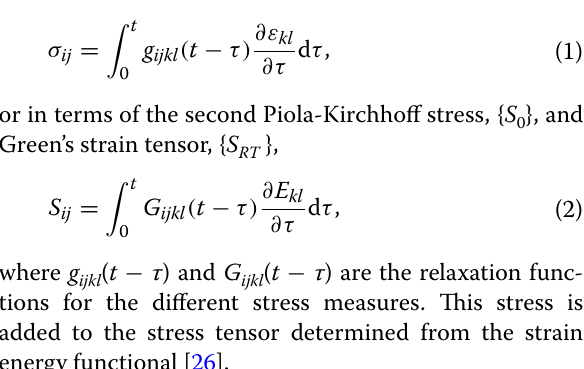
ratio is 0.495. Firstly, with the initial boundary condi- tions applied, a same sized discrete model of the rubber specimen has been established, as shown in Figure 2(a). Solid elements with one integration point were chosen for large deformation analysis of the tire rubber material. This element is sufficient efficient and accurate, however, hourglass control is also needed in each case [14]. Sec- ondly, a test prescribed motion was applied on the top surface of the specimen to simulate its uniaxial compres- sion. Finally, the axial forces will be compared between simulations and test results for material correlation. The force versus displacement curves acquired from numerical simulation and test data with different strain rates are shown in Figure 3(a). It can be seen that the curves from experimental and numerical tests have good agreement for various strain rate, and evident strain rate dependency can be noticed. The comparisons results show that the constitutive model selected can accurately describe the response of rubber specimen during com- pression with various strain rates. In addition, the test data of tire rubber with high strain rate (5700 s − 1 and 3800 s − 1 ) were acquired from dynamic split Hopkinson pressure bar test by Baranowski et al. [22]. The drop hammer was used to perform experimental tests with dynamic conditions. The aim of the dynamic experiments was to validate the rubber model under dynamic loading condition. The drop hammer has a weight of 5 kg, the impact height is 2 m, giving an energy of 100 J. In these tests, the rubber specimens